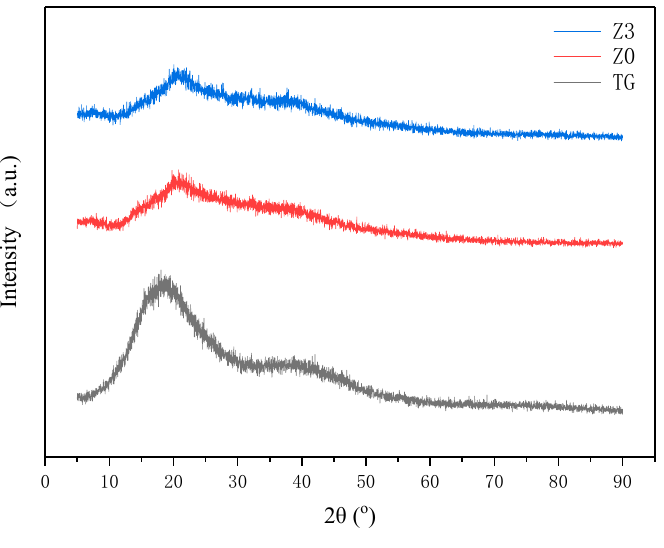
Figure 3. X ‐ ray diffraction pattern of TG, Z0 and Z3 . Figure 3. X-ray diffraction pattern of TG, Z0 and